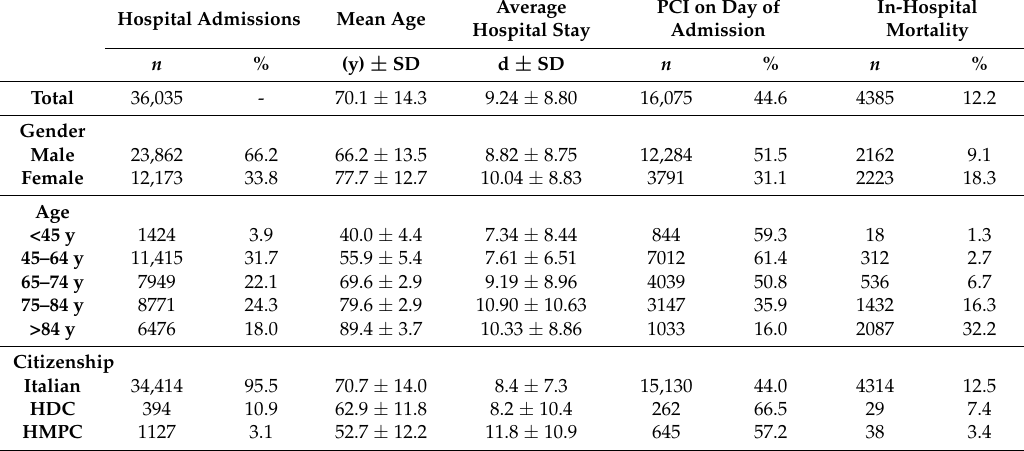
Table 1. Veneto Region 2007–2016. Characteristics of hospital admissions for STEMI, in-hospital mortality and proportion of PCI on day of admission by gender, age, and citizenship. Hospital Admissions Mean Age